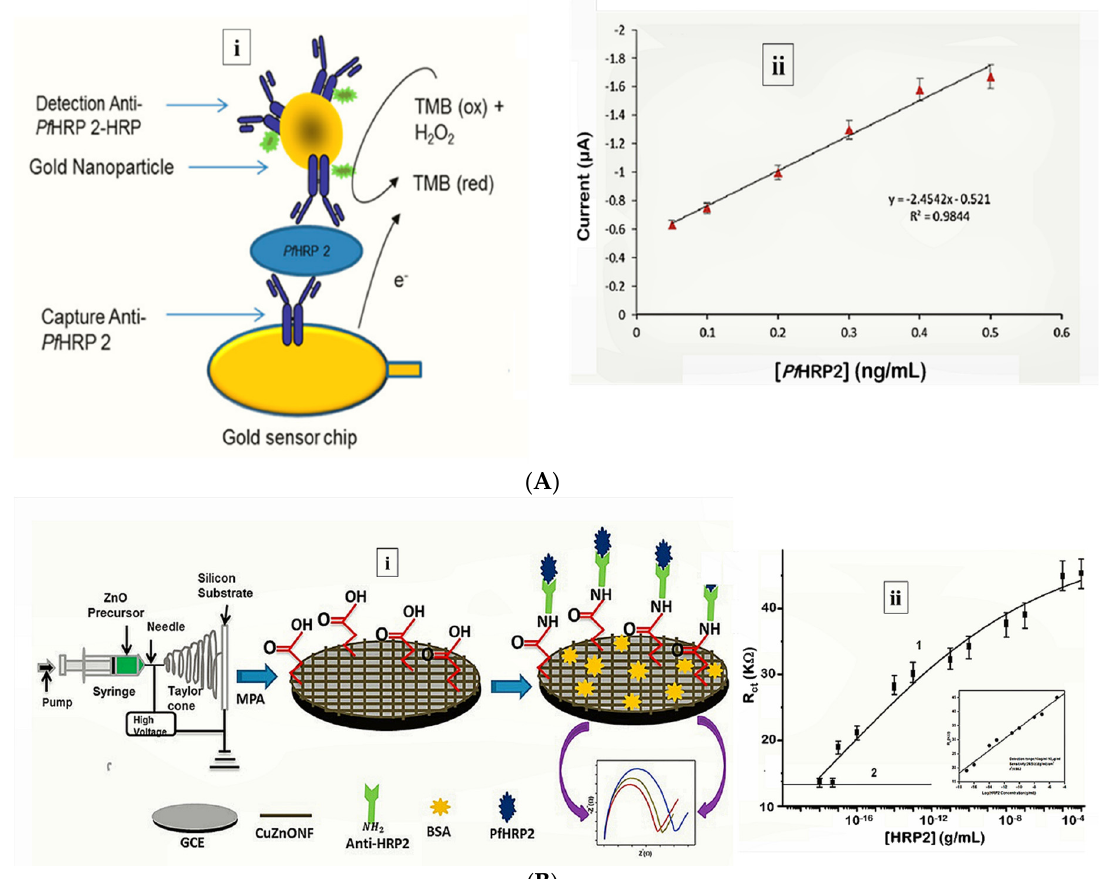
Figure 2. Strategy for ( A ) labelled amperometric [60] and ( B ) label free impedimetric [57] electrochemical detection of PfHRP-2. ( A ) ( i ) Gold nanoparticle amplified sandwich assay and ( ii ) plot of chronoamperometric response of PfHRP-2 detection in spiked serum (0.05–0.5 ng/mL PfHRP). Reprinted from Hemben et al. [60] with permission from MDPI. ( B ) ( i ) CZnONF dispersions drop-casted onto GCE followed by chemisoption of anti-HRP2 unto MPA treated electrodes and ( ii ) calibration curve of impedimetric responses obtained after incubating GCE/fCuZnONFs/Anti-HRP2 biosensor with varying concentrations of PfHRP2 (10 ag/mL–10 µg/mL). (Adapted from Paul et al. [57] with permission from Elsevier).